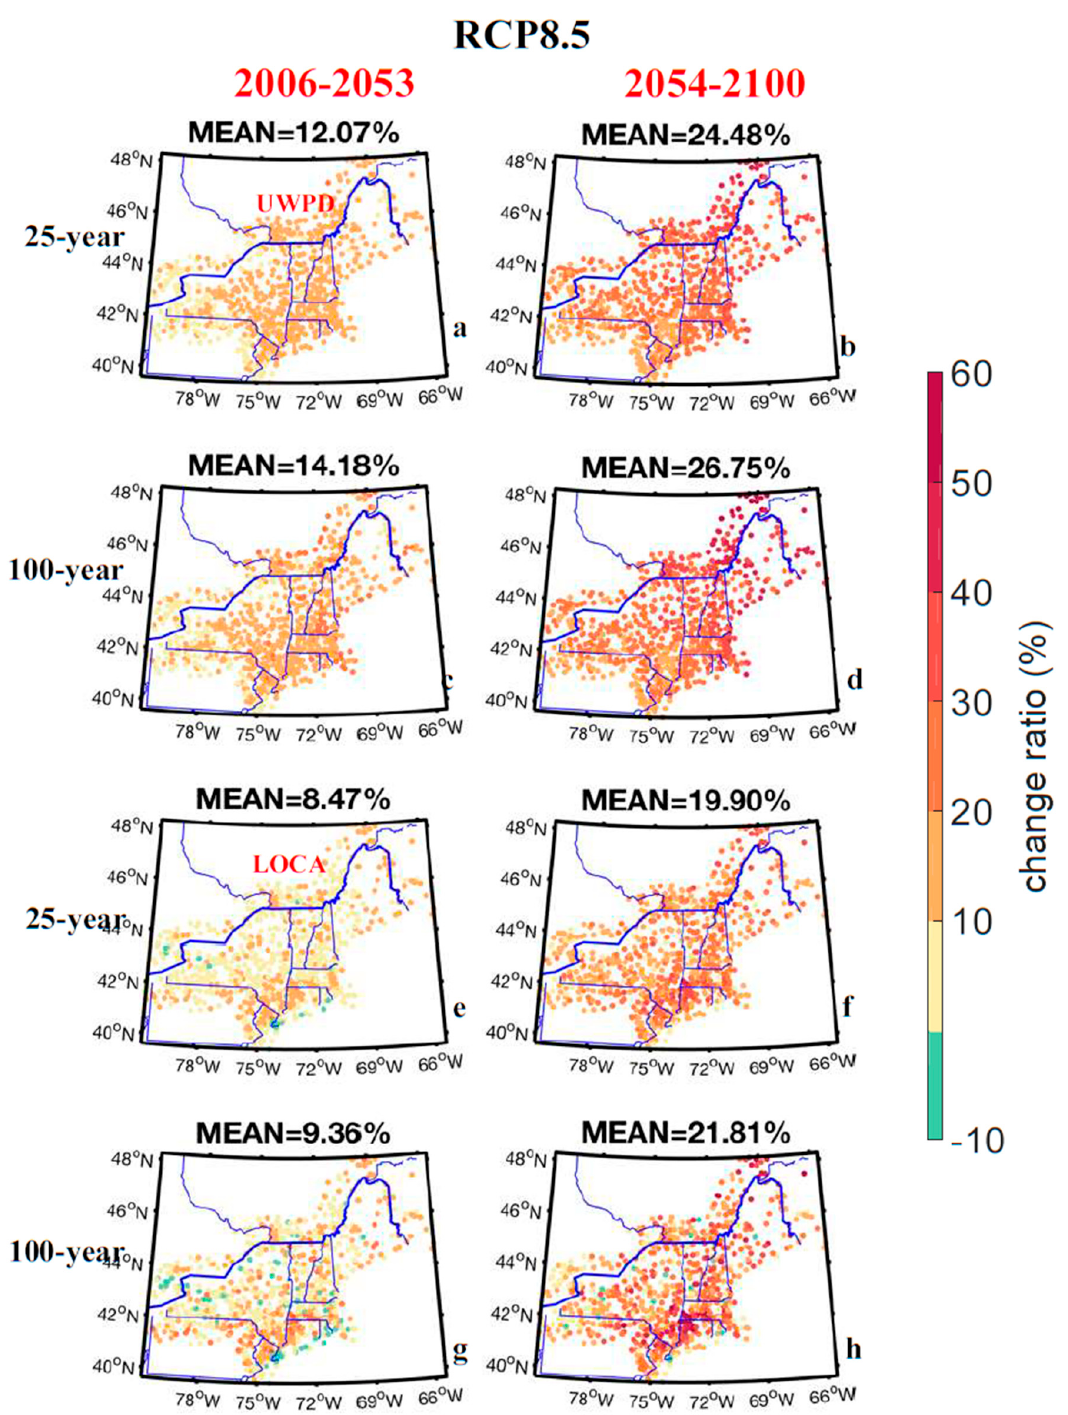
Figure 9. Relative PF difference ratios defined as (PF_future – PF_historical)/PF_historical for a 25- year return period ( a , b , e , f ) and a 100-year return period ( c , d , g , h ) under the RCP8.5 emission scenario.